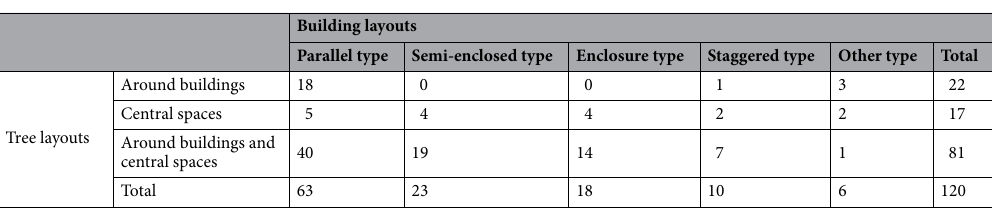
Table 1. Statistics of the arrangement of buildings and trees in selected communities of Shijiazhuang City.